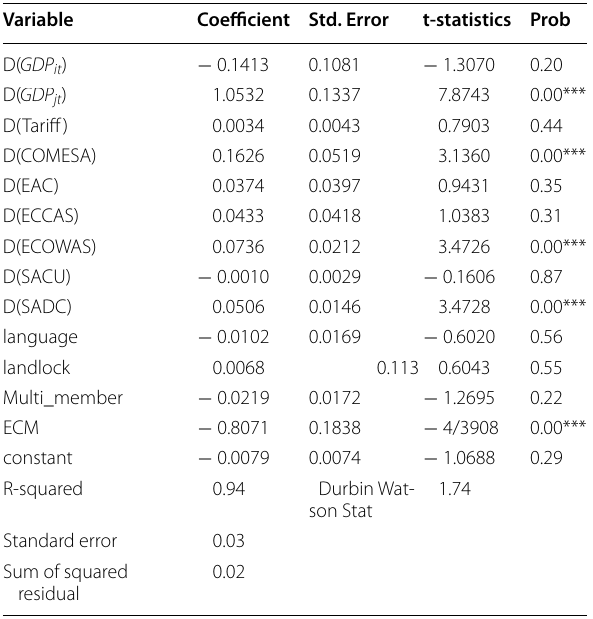
Table 6 The short run result. Dependent variable: D(export ijt